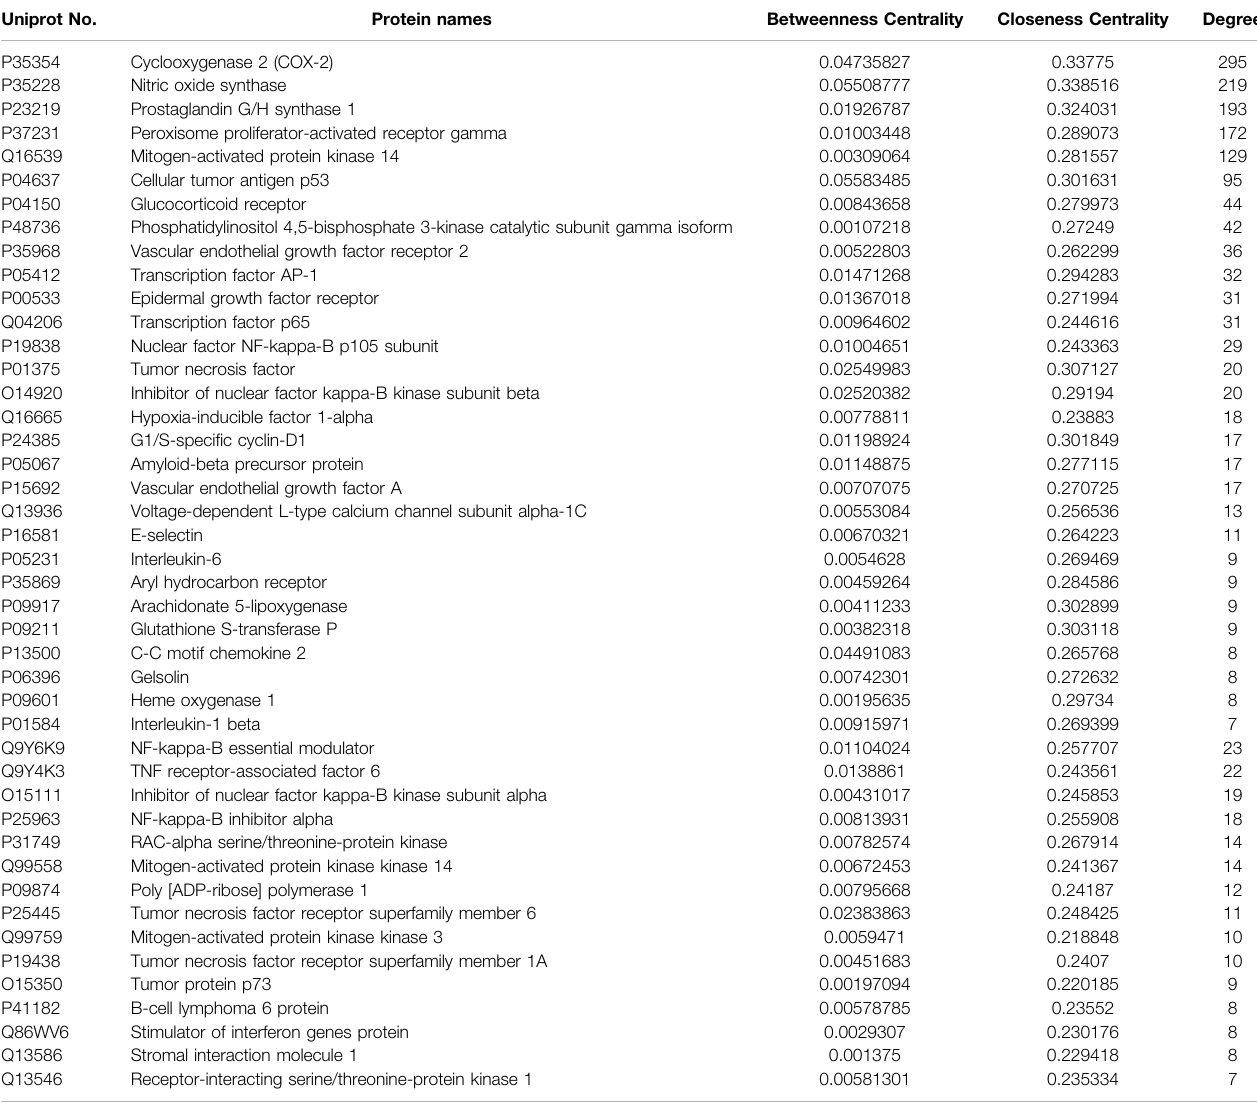
TABLE 1 | The related topological parameters of LHQW in the treatment of in fl ammation. Uniprot No.